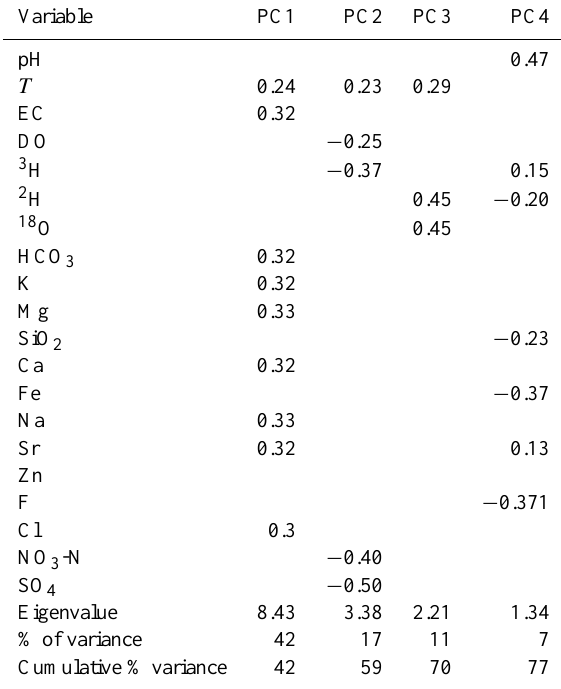
Table 3. Rotated component matrix of the factor analysis for groundwater samples from the Atemajac–Toluquilla aquifer system. Coefficients between − 0.1 and 0.1 are suppressed. Note: DO repre- sents dissolved oxygen, T represents temperature and EC represents electrical